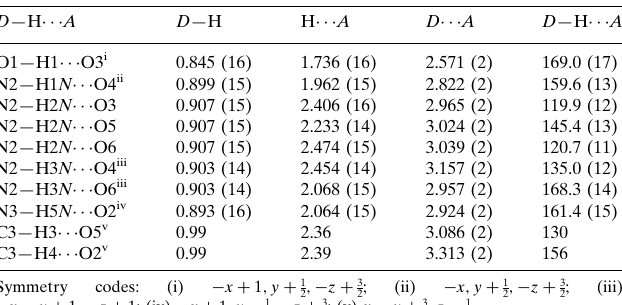
Hydrogen-bond geometry (A˚ , (cid:4) ). D —H (cid:2)(cid:2)(cid:2) A D —H